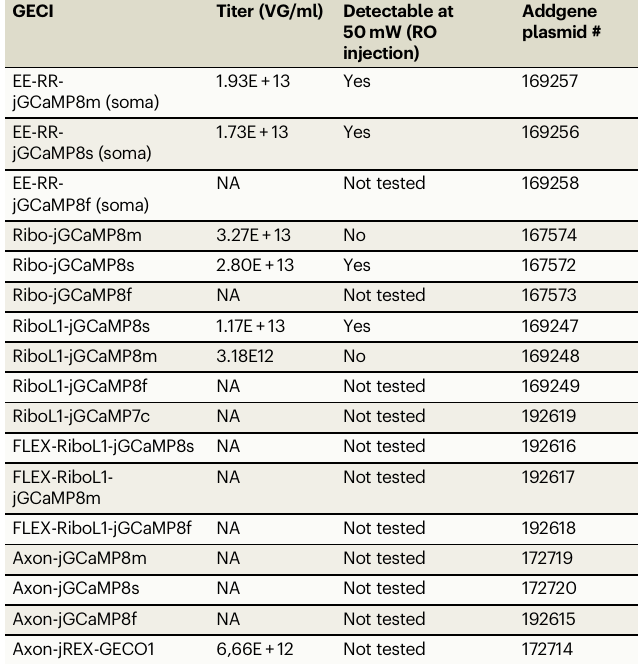
Table 2 | Soma and axon-targeted GECI constructs prepared in this work